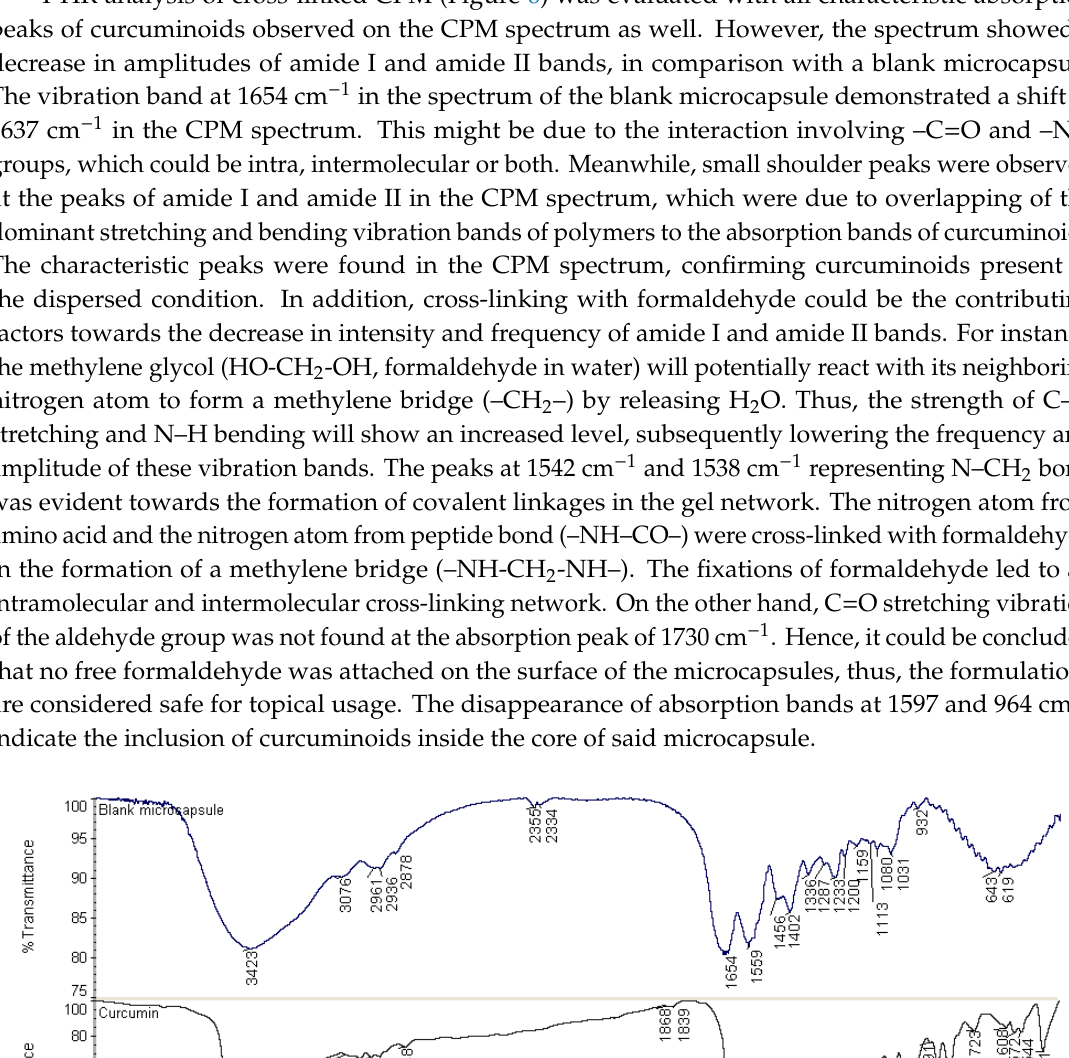
Figure 7. Swelling indexes of curcuminoids microcapsules in different media at 35 ± 2 °C. Mean ± standard deviation (SD), n = 3. 01020